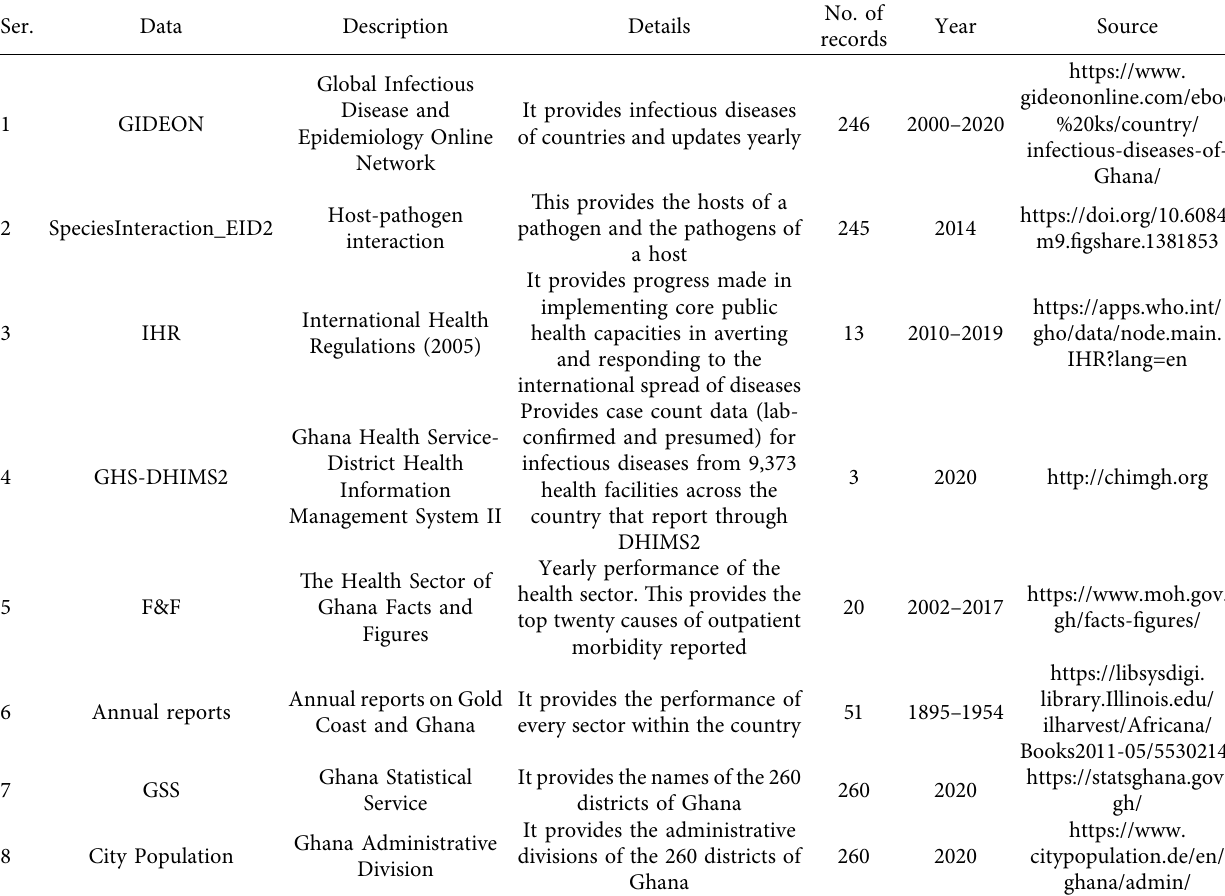
Table 1: List of data sets used for the study. It indicates the description of data and source.